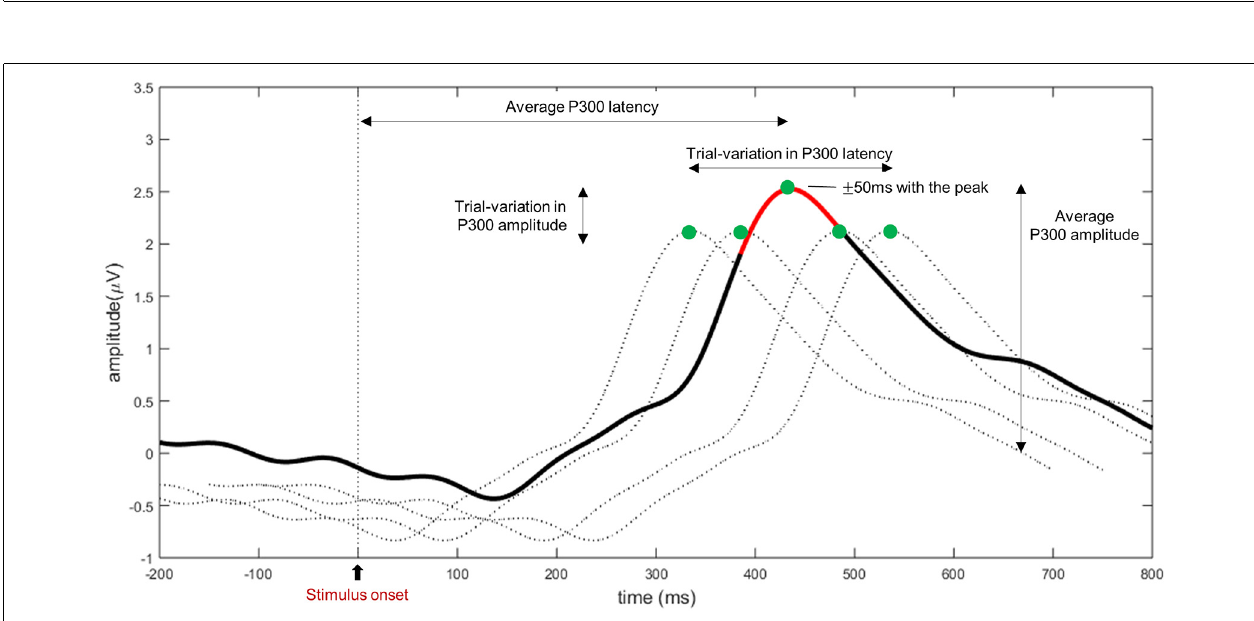
FIGURE 2 | Event-related potential (ERP) features in the RSVP: P300 amplitude, P300 latency, trial variation in the P300 amplitude, and trial variation in the P300 latency. The bold line indicates the trial averaged P300, and dashed lines indicate single P300 trials (the same P300 response was presented for visual representation in this figure). For each electrode, P300 amplitude is defined as the time average of neighbor 50 ms with the peak amplitude (green dot: peak, red line: neighbor 50 ms with the peak), and the corresponding peak time point is regarded as the P300 latency. In addition, trial variations in the P300 amplitude and latency are defined as the inter-trial standard deviation of amplitude and latency,